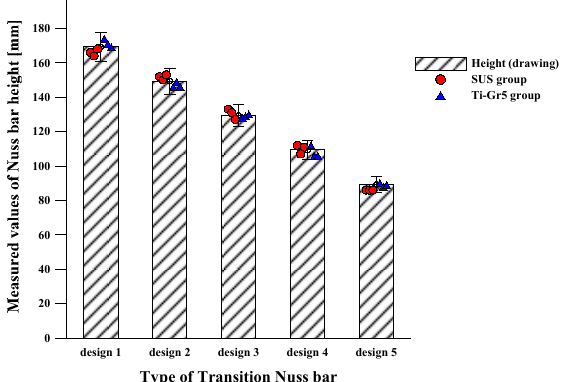
Figure 18. Results for the dimension accuracy of the SUS and Ti-Gr5 transition Nuss bar. This histogram shows the maximum width of the SUS and Ti-Gr5 transition Nuss bars. Widths were measured and compared with original width.